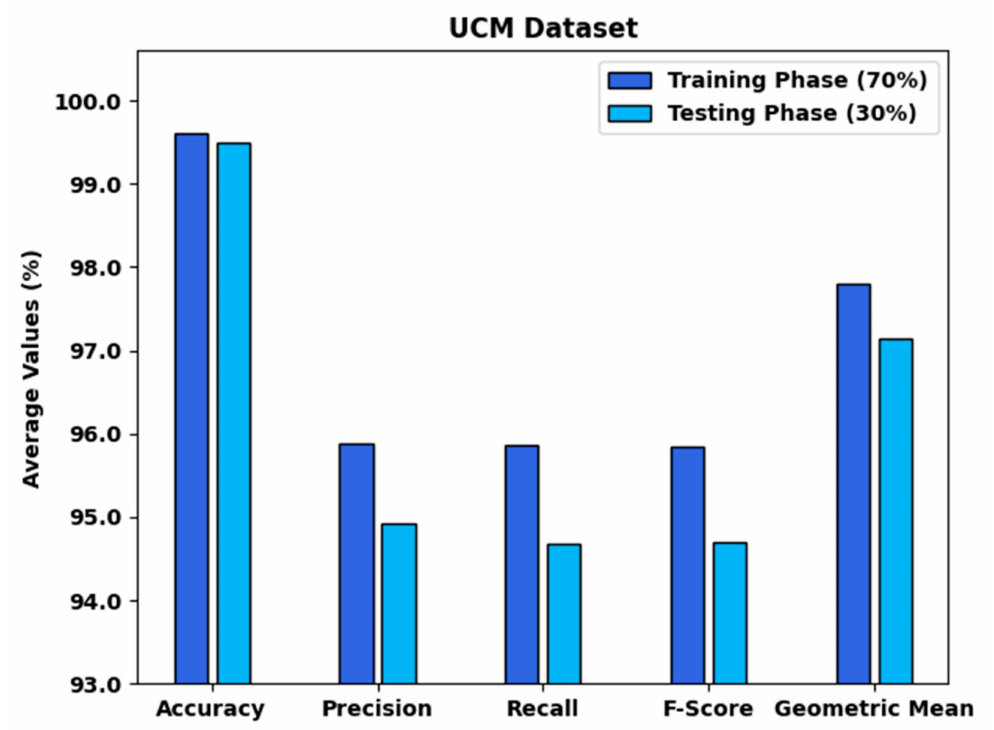
Figure 10. Average analysis of SIDTLD-AIC technique with various measures.